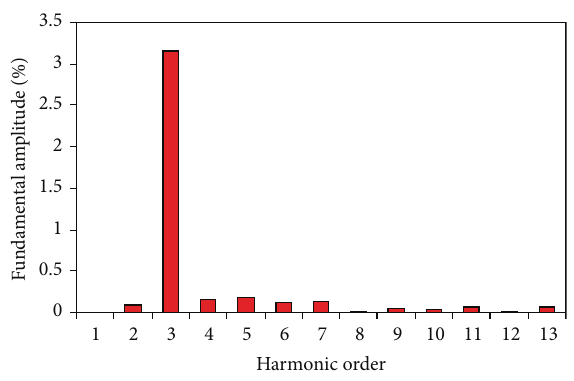
Figure 16: Harmonic distributions of back-EMF.